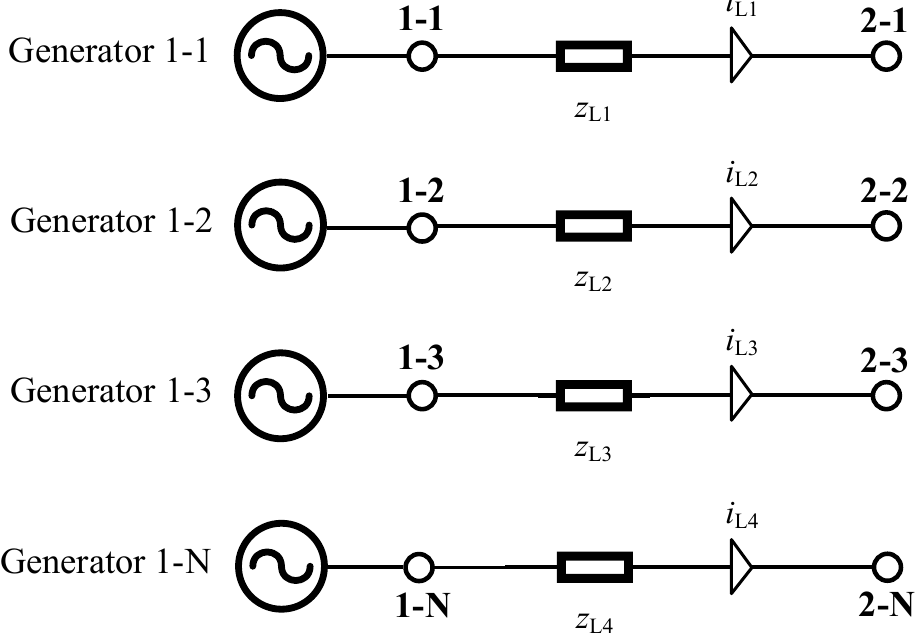
Figure 2. Model of the grid for three-phase OPF